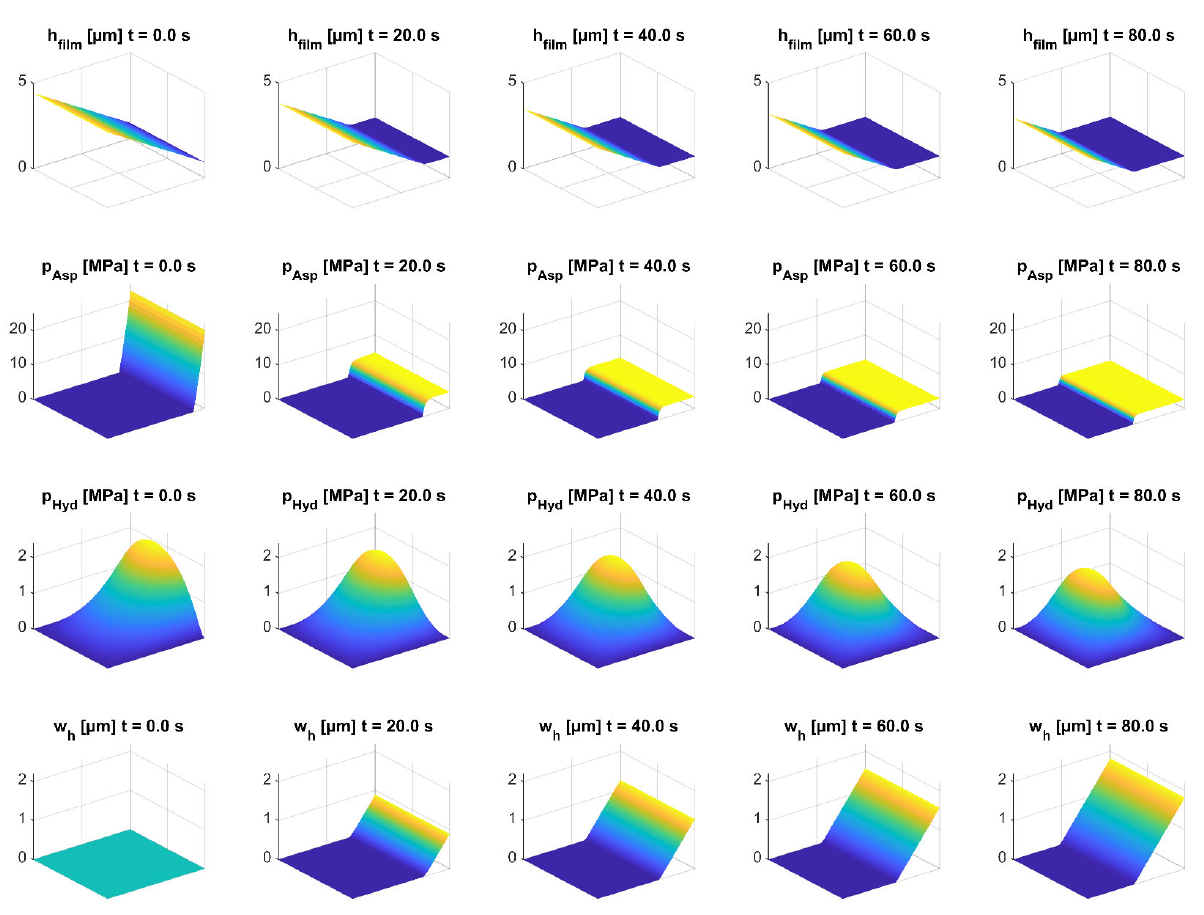
Figure 9. Plot of the time dependent lubrication gap height, asperity contact pressure, hydrodynamic pressure, and wear height for the smooth lubrication wedge.